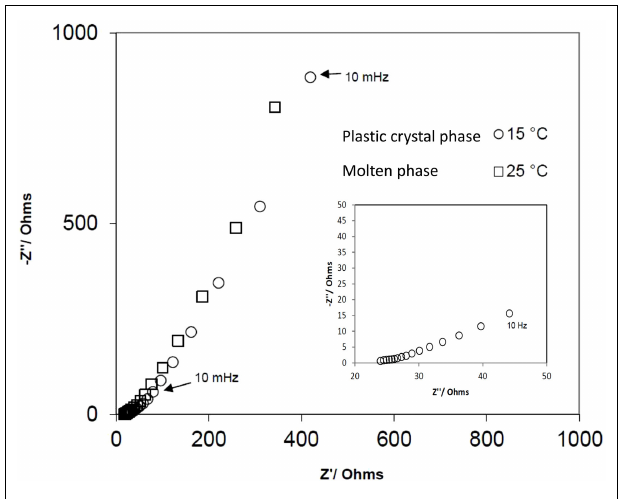
FIGURE 4 | AC impedance spectra of the EDLC utilizing the SCN-10%TBA-PF 6 in the plastic phase (15°C) and the molten state (25°C) . Inset shows the high frequency region for the plastic phase.